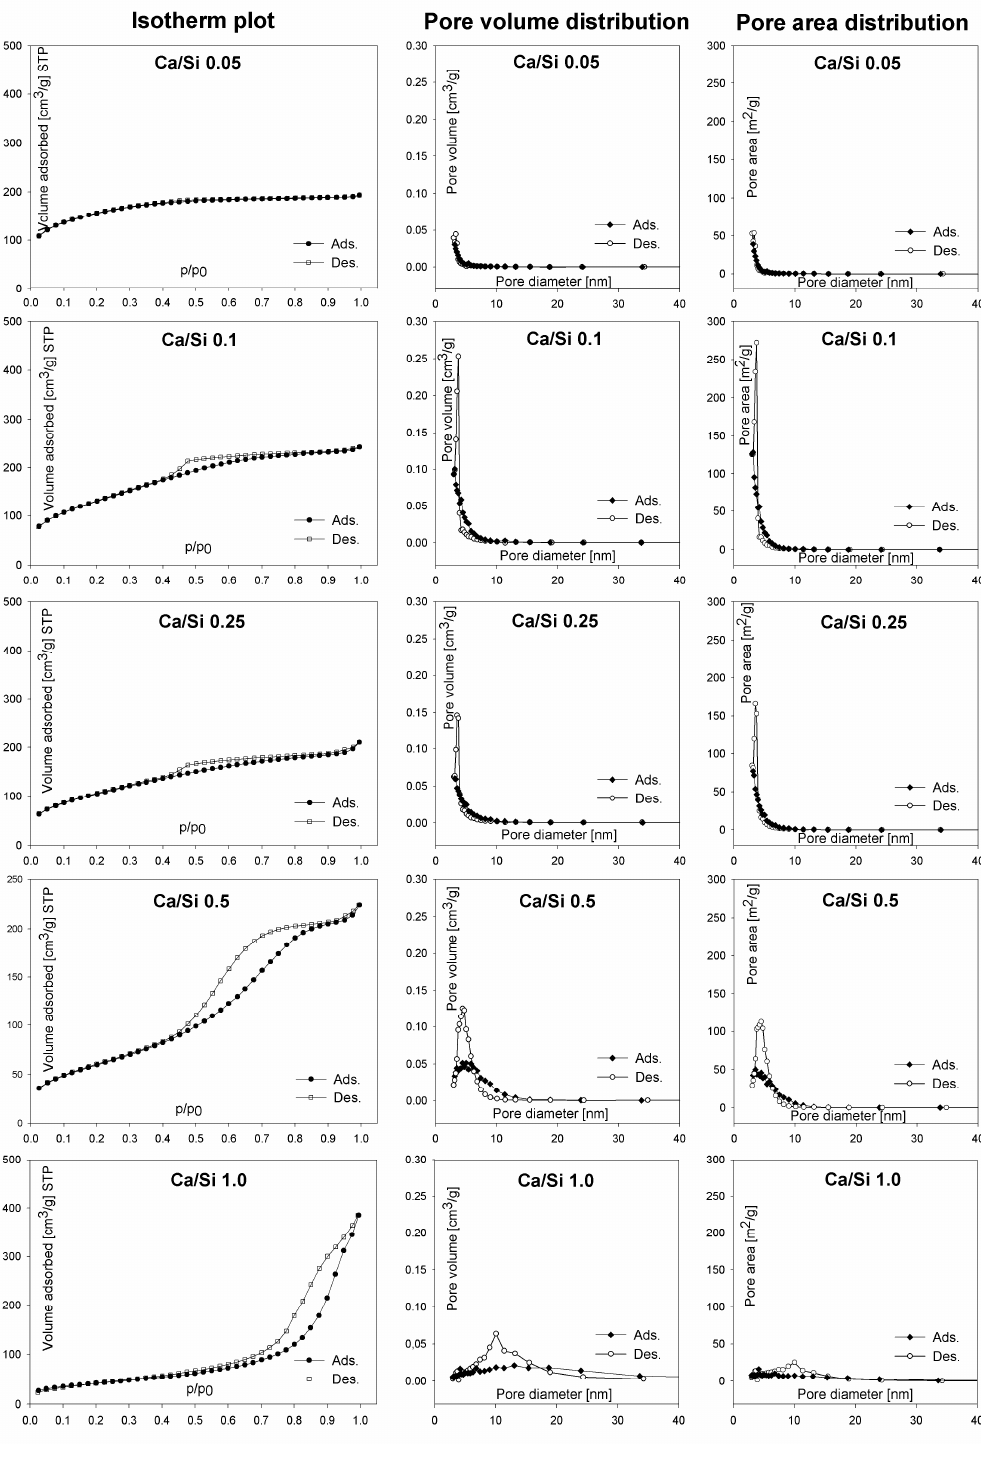
Figure 6. Isotherm, pore volume distribution and pore area distribution of Ca/Si systems. Binary systems based on SiO 2 with low calcium content have a high initial surface area (~500 m 2 /g) [28], that decreases almost linearly with the increasing content of the latter component. Small mesopores of an average size of approximately 3–4 nm have a major contribution to the surface area and their initial distribution is in a narrow range. Significant amounts of larger mesopores were not found. The low initial pore volume of the binary systems increases with the calcium content in the silica matrix; however, the